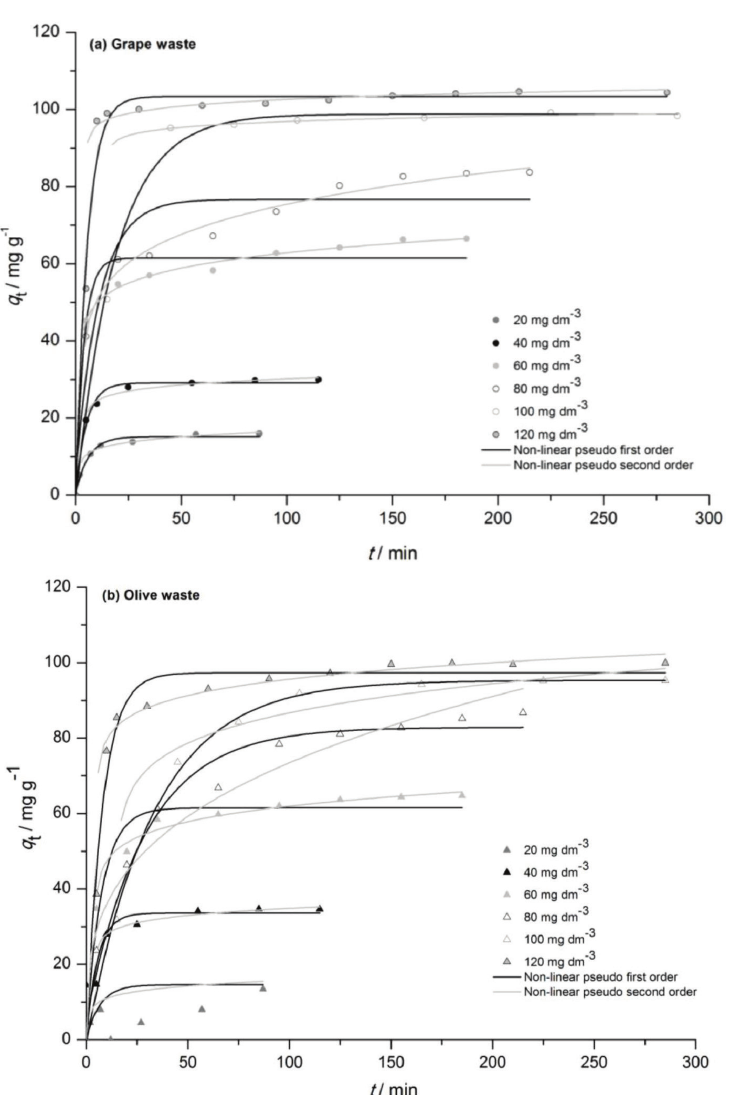
Fig. 9 – Experimental data and fitted non-linear forms of pseudo-first-order and pseudo-second-order equations for the adsorption of Cr(VI) on grape waste (a) and olive waste (b) (m = 0.05 g, V = 100 cm 3 , pH = 2 and T = 20 0